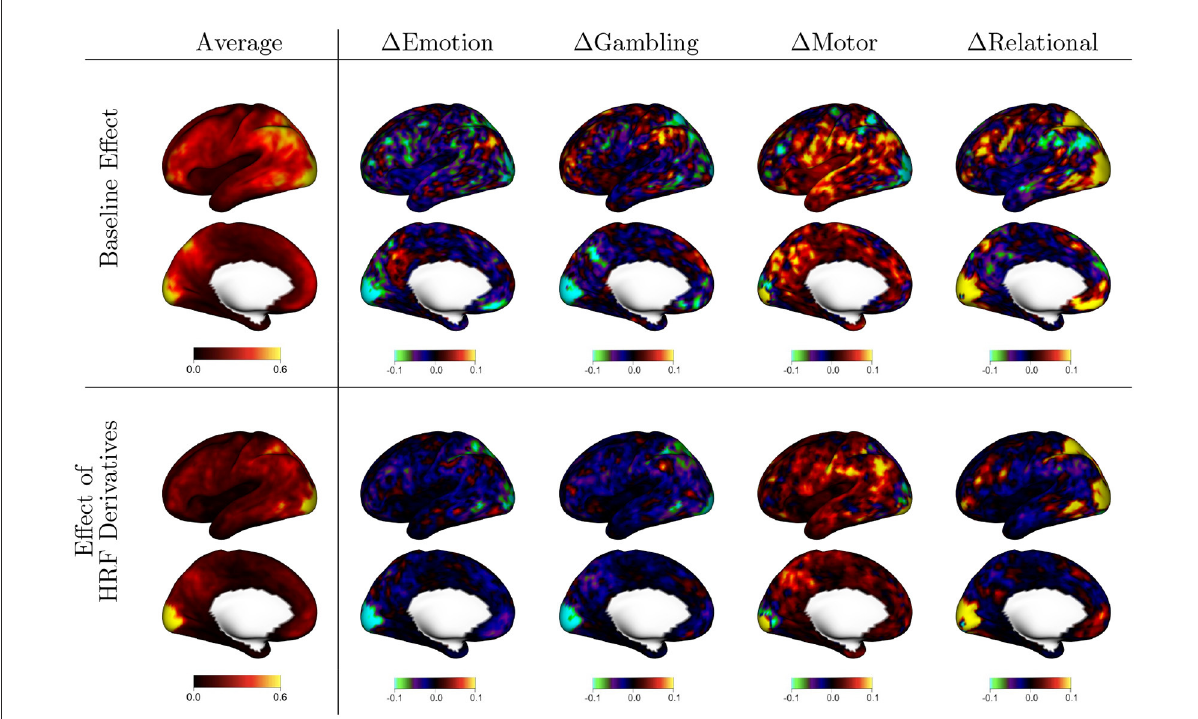
FIGURE3 Population variability in the effects shown in Figure 2, based on the random effect (RE) standard deviations (SD) from model (2). The first column shows the average across tasks, indicating general spatial patterns of population variability. The other columns show the difference between each task and the average, indicating areas of greater (warm colors) or lesser (cool colors) variability during specific tasks. The first row shows variability in autocorrelation when assuming a canonical HRF [ a k , i ( v )]; the second row shows variability in the effect of using HRF derivatives to allow for differences in HRF shape [ b k , i ( v